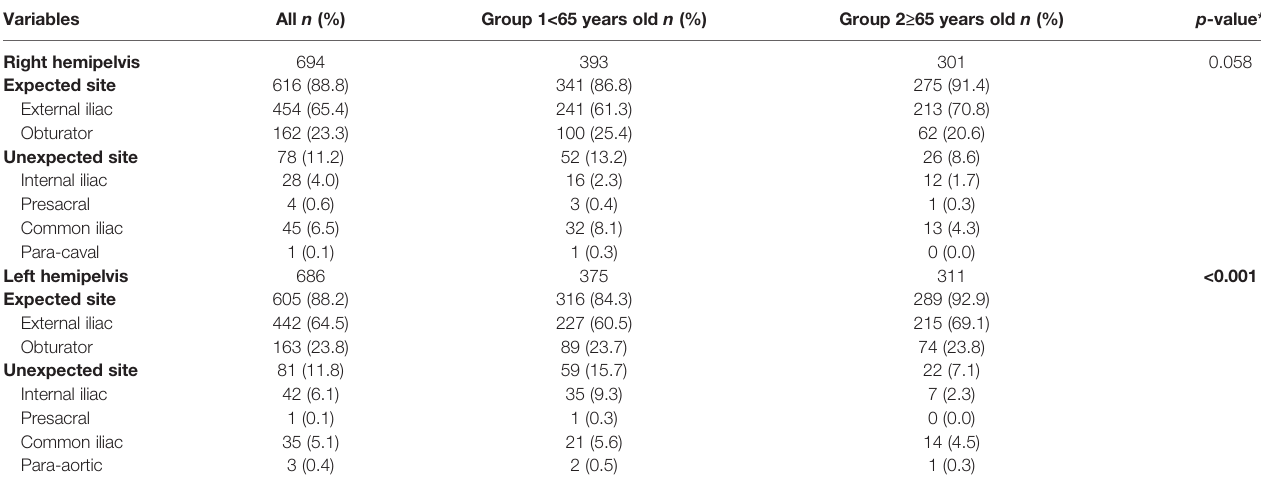
TABLE 3 | Anatomical localizations of sentinel lymph nodes. Variables